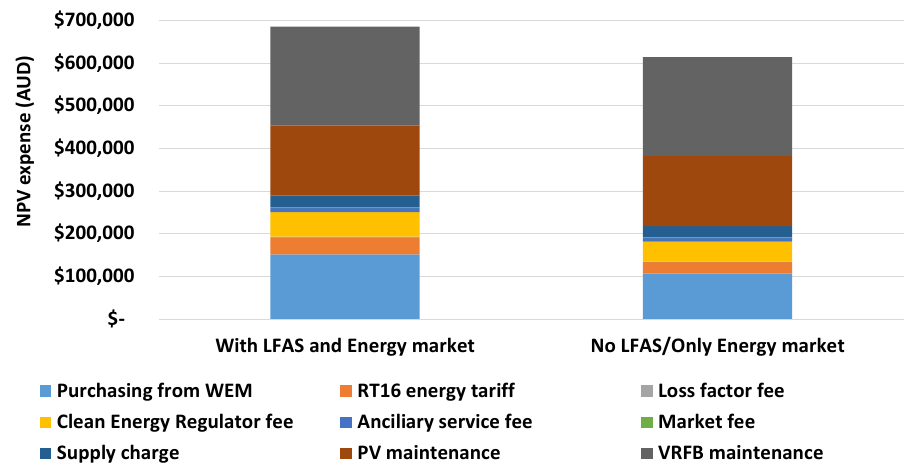
Figure 11. The components of the NPV of expense with and without participation in LFAS market.